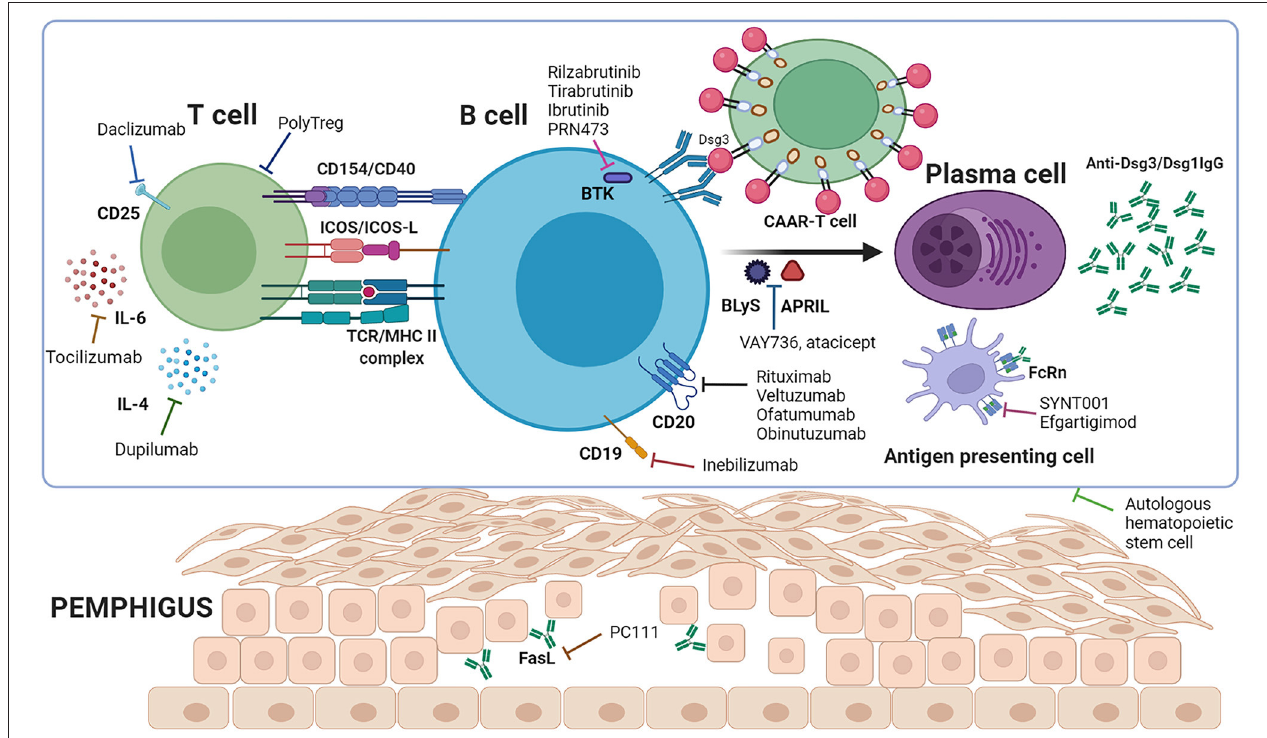
FIGURE 1 | Immune mechanism of pemphigus and targeted therapeutic agents. T cells interact with B cells to provide co-stimulatory signals through CD154/CD40, ICOS/ICOS-L etc., leading to B cell activation, proliferation, and differentiation to plasma cells, and secretion of anti-Dsg3/Dsg1 autoantibodies. Binding of the antibodies to the target antigen among acanthocytes leads to the separation of keratinocytes and intraepidermal blister formation. Rituximab, veltuzumab, ofatumumab, obinutuzumab and inebilizumab deplete autoreactive B cells to prevent their differentiation to plasma cells. PolyTregs, daclizumab, tocilizumab and dupilumab act on T cells, while rilzabrutinib, tirabrutinib, ibrutinib, PRN473, VAY736 and atacicept target B cells, resulting in less activation of autoreactive B cells. CAAR-T cells work to eliminate Dsg3-specific B cells. SYNT001 and efgartigimod saturate FcRn to shorten the half-life of pathogenic IgG autoantibodies. Autologous hematopoietic stem cells function by eliminating autoreactive lymphocytes and re-establishing the immune system (Created with BioRender.com).